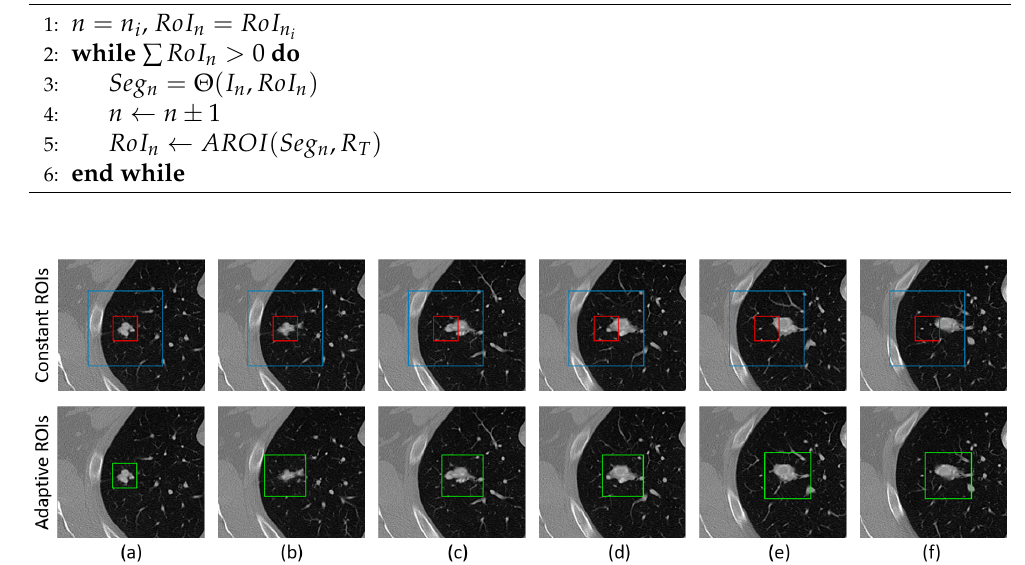
Figure 4. Constant and adaptive regions of interest (ROIs) are depicted in a series of consecutive slices containing a nodule from column ( a – f ). Te segmentation of the nodule starts from column ( a ) with the manual ROI and ends at column ( f ). The blue and red bounding boxes represent constant ROIs, while the green boxes represent adaptive ROIs. (Figure credit: Usman et al.